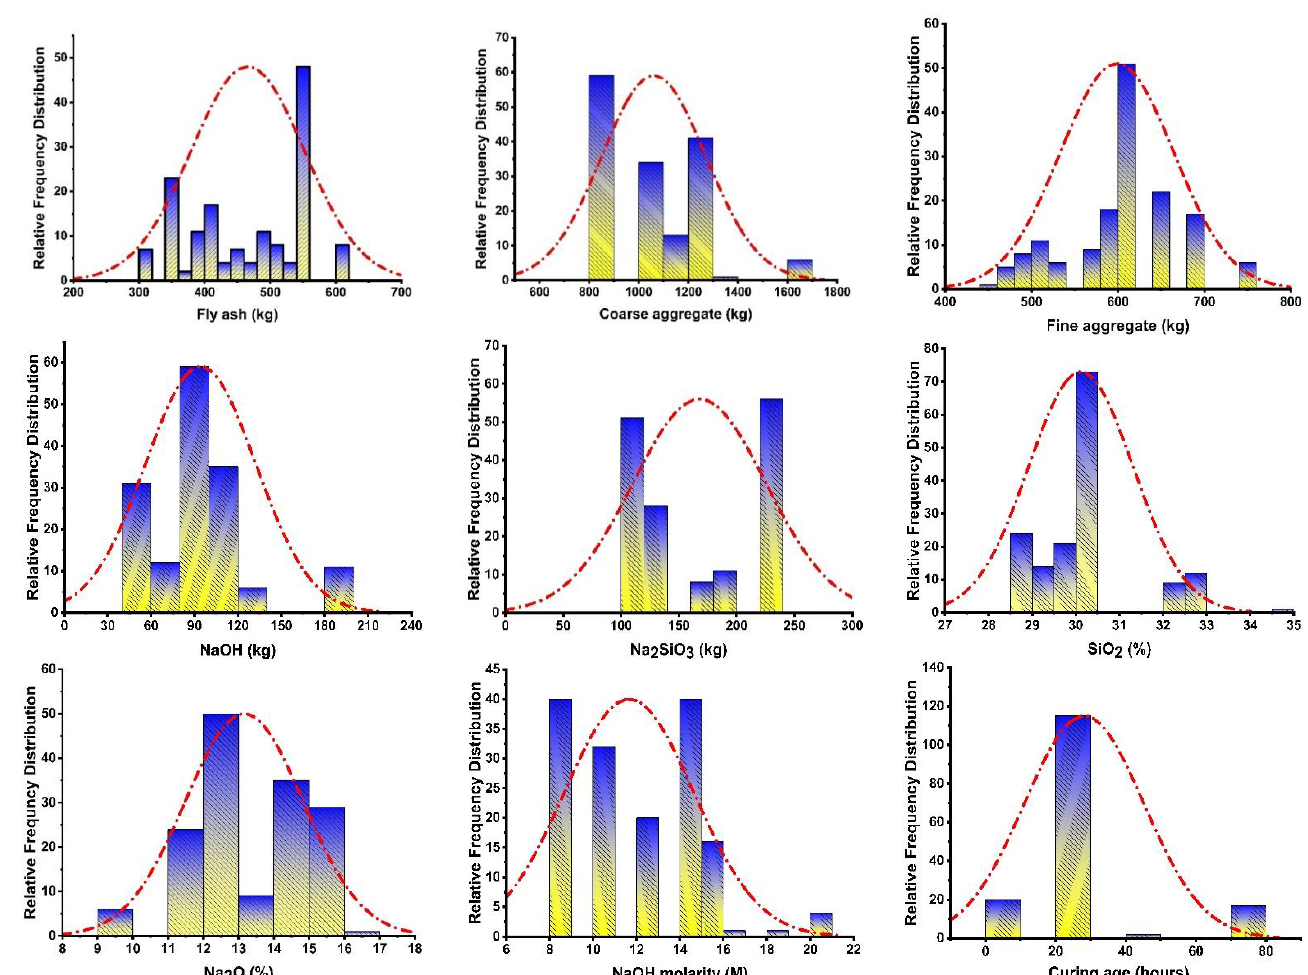
Figure 1. Relative frequency distribution of the input variables.